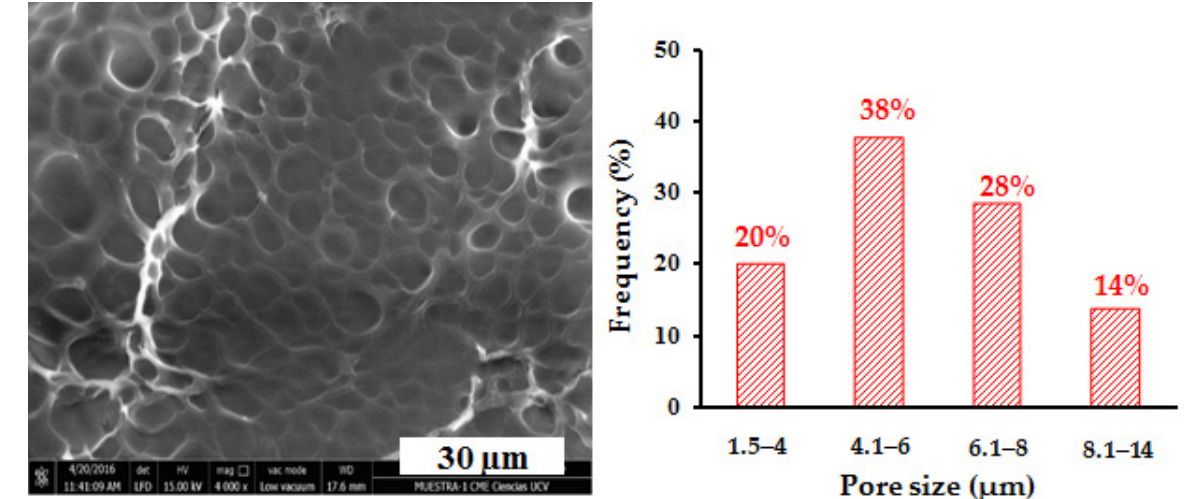
Figure 17. Micrograph obtained by SEM for the conventional polyacrylamide hydrogel (n =